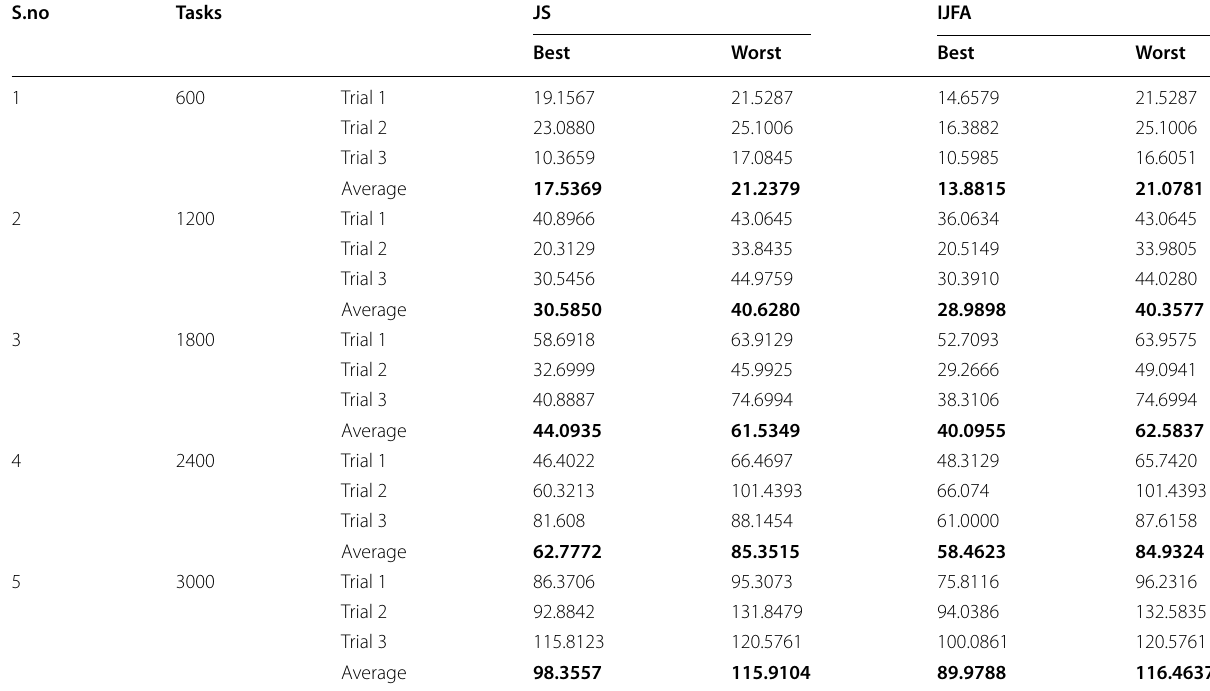
Table 5 Summary of ECT observations for varying number of tasks for JS and IJFA S.no Tasks